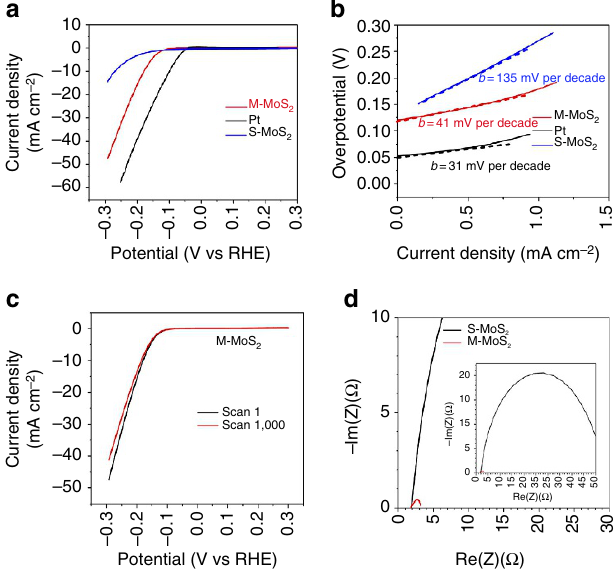
Figure 4 | HER activity of the synthesized MoS 2 nanosheets. ( a ) Polarization curves of the M-MoS 2 and S-MoS 2 nanosheets. ( b ) Corresponding Tafel plots obtained from the polarization curves. The Tafel slopes were B 41 and B 135mV per decade for M-MoS 2 and S-MoS 2 , respectively. ( c ) Polarization curves of the M-MoS 2 nanosheets after 1 and 1,000 cycles of continuous operation. ( d ) Nyquist plots of M-MoS 2 and S-MoS 2